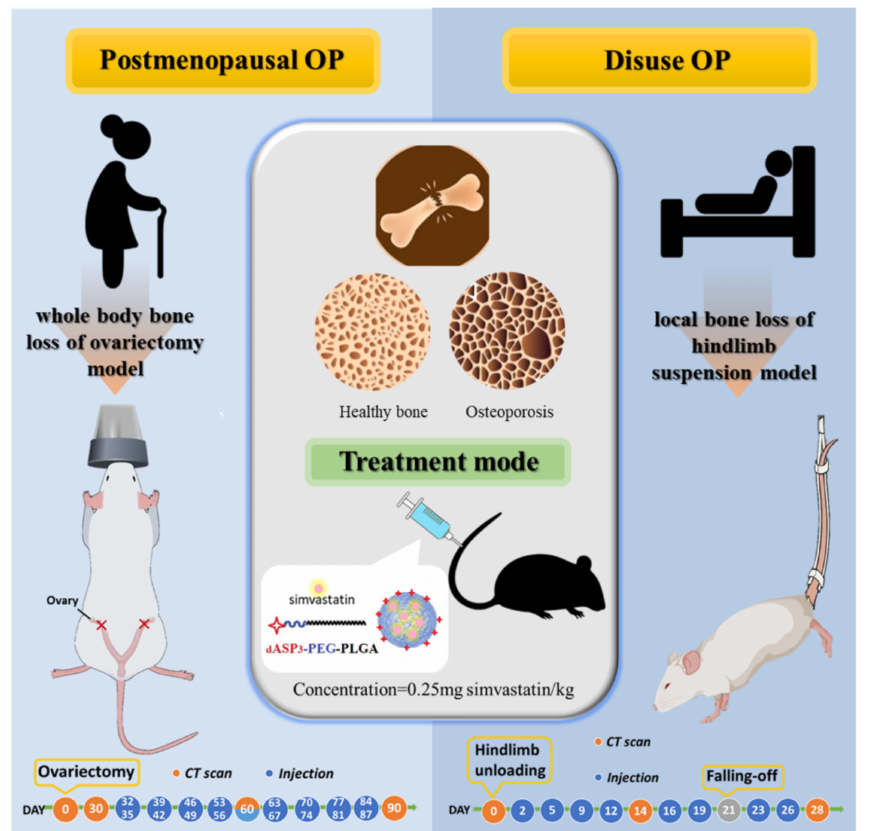
Figure 1. Scheme of the main research framework and objectives for the novel bone-targeting moiety of dendritic oligopeptide by three aspartic acids ( d Asp 3 ) and amphoteric polymer (poly(ethylene glycol-block-poly(lactic-co-glycolic acid); PEG-PLGA) to create d Asp 3 -PEG-PLGA (APP) nanoparti- cles (NPs) with bone-targeting capability, which will carry SIM to treat osteoporosis disease. Osteo- porosis in the animal model will be classified into the primary type of postmenopausal model for systemic bone loss using the ovariectomized (OVX) method and the secondary type of disuse model for local bone loss using the hindlimb suspension